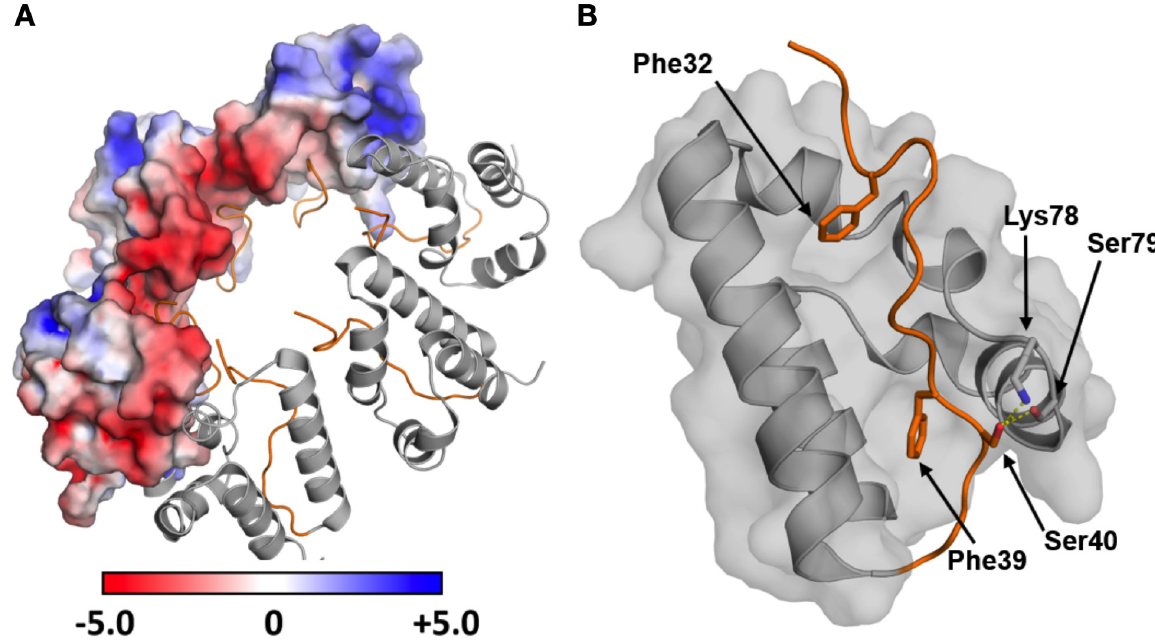
Fig 3. The N-terminal region preceding dArc-NL packs into the hydrophobic core of the domain and leads to the formation of the capsid hexamer. (A) The hexameric form of dArc2-NL observed in the capsid (PDB: 6TAQ; [21]), showing the electrostatic surface potential for half of the monomers. The canonical fold enables contact formation between the oppositely charged surfaces of each monomer. The N-terminal tail is showed in orange. (B) Residues contributing to the packing of the N-terminal tail (orange) into the capsid hexamer. Phe32 and Phe39 pack into two exposed pockets in the hydrophobic core. Further interactions are observed for Ser40, which hydrogen bonds directly with Lys78 and Ser79 in the α 2 kink (yellow dashed